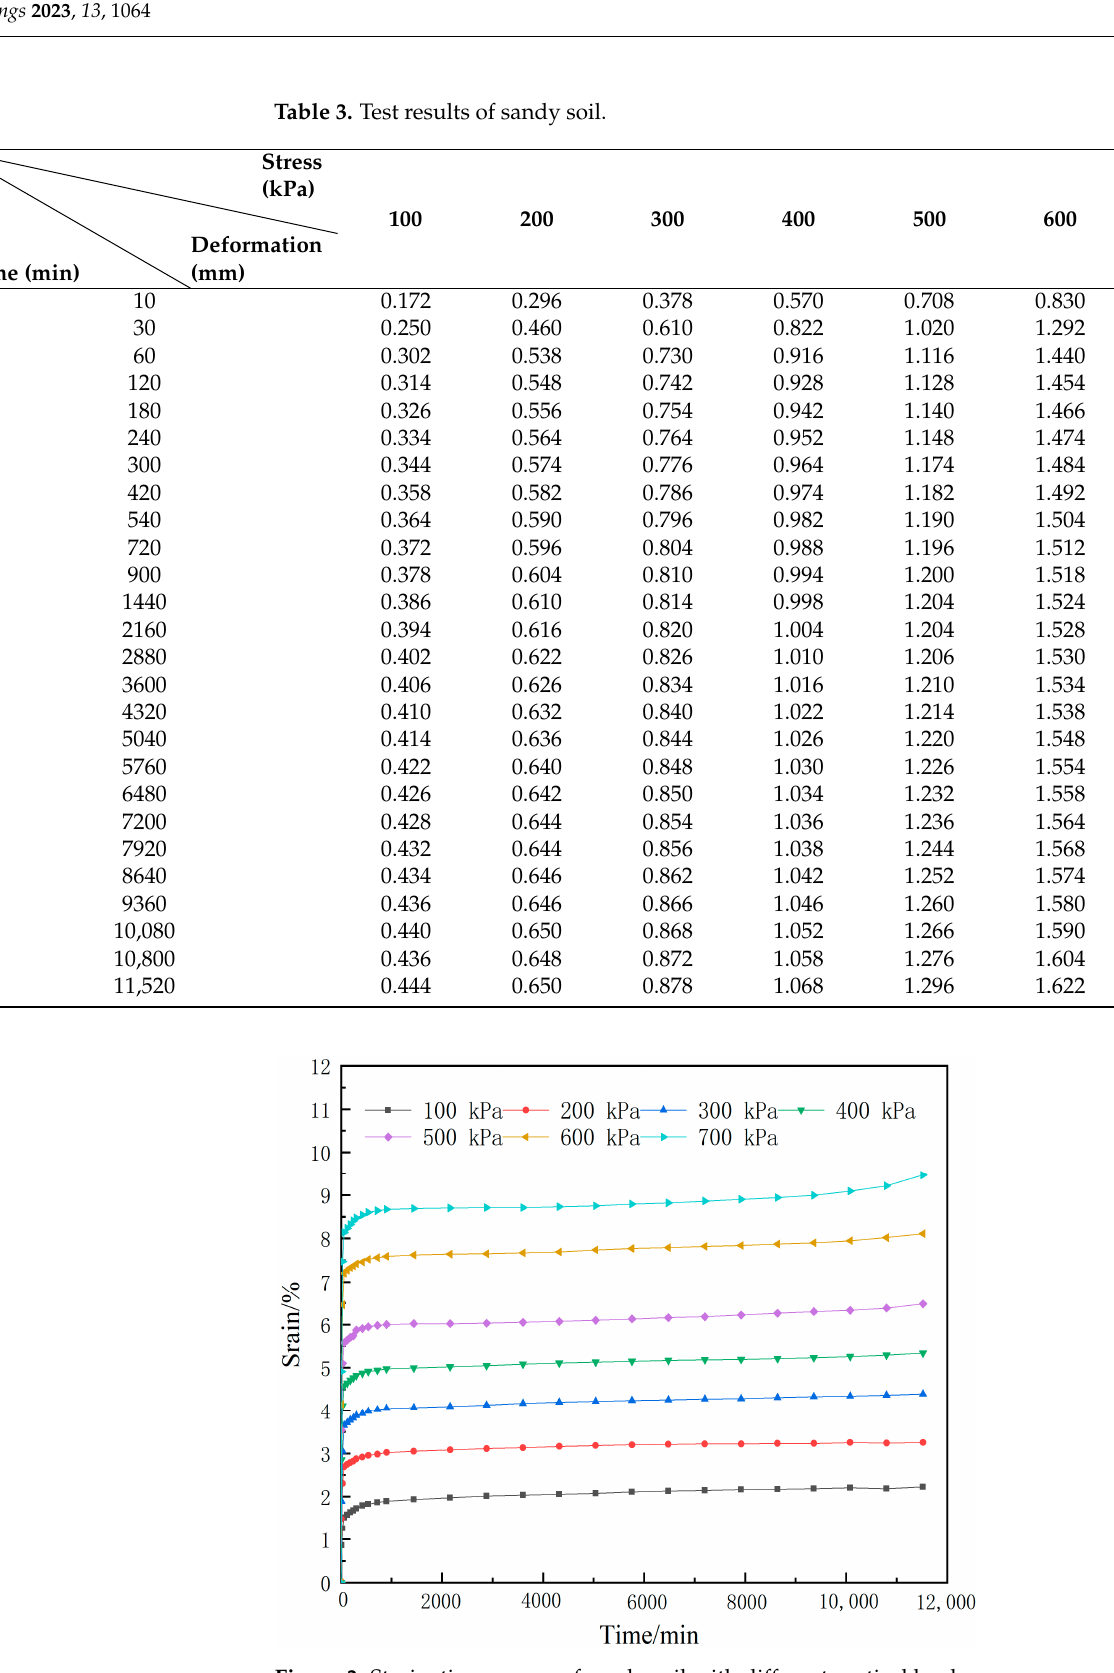
Table 2. Experimental scheme for creep test of soil samples.